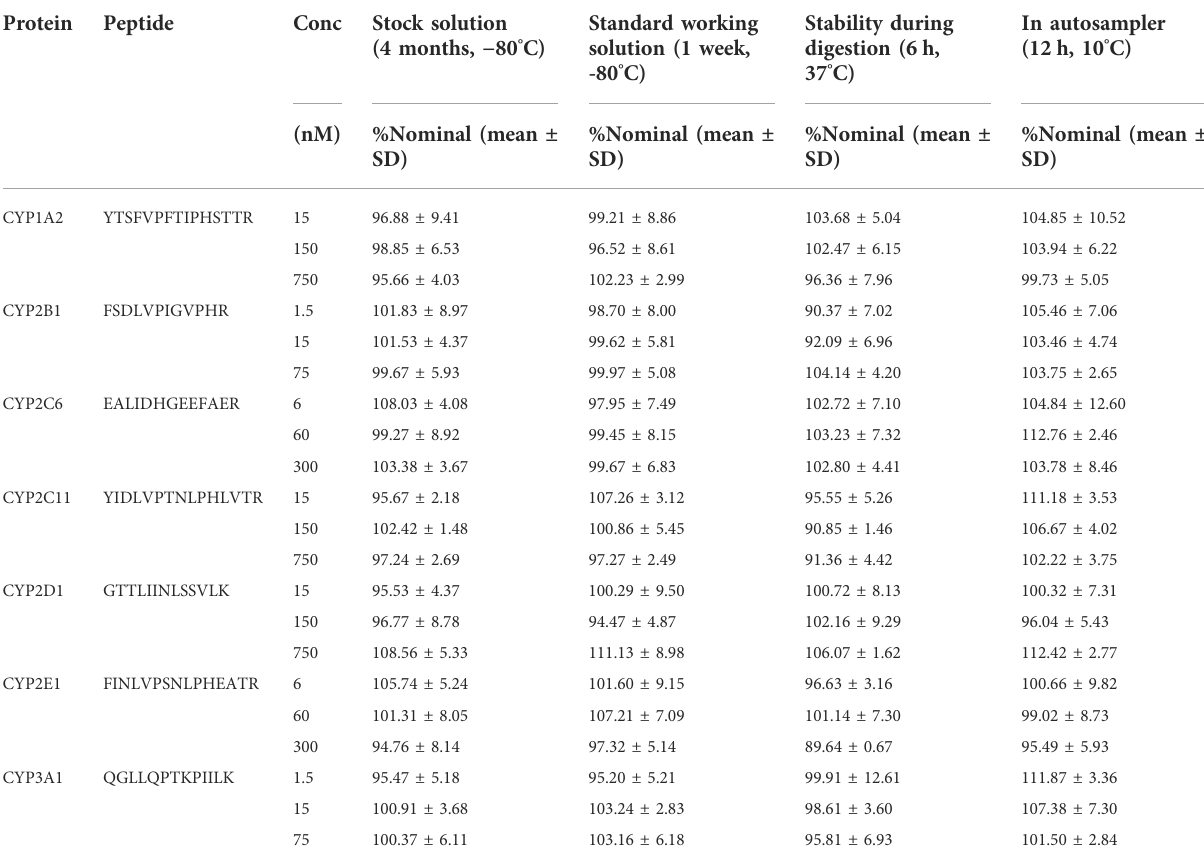
TABLE 3 Stability of seven surrogate peptides. Results are expressed as percent nominal ±SD ( n = 6).